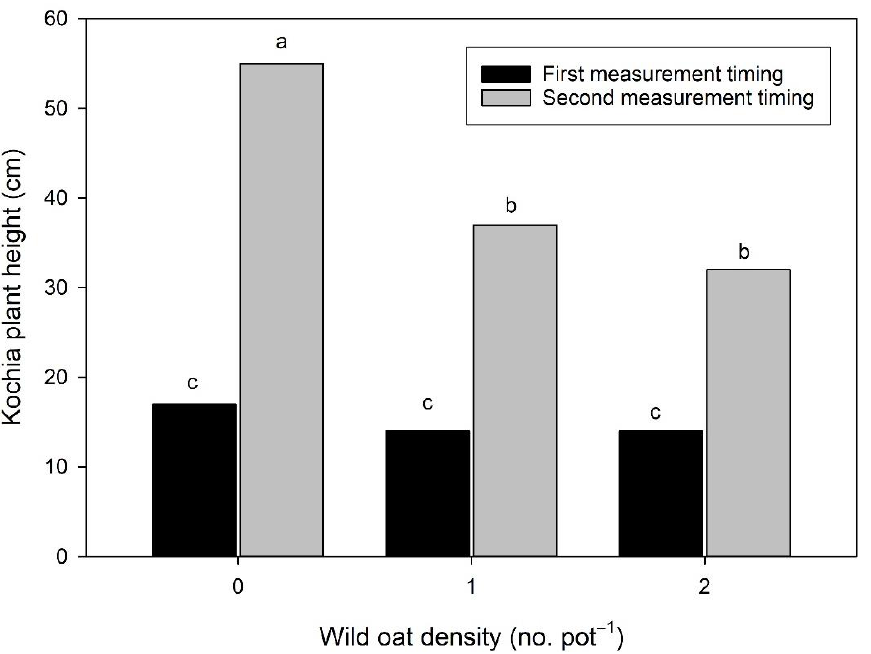
Figure 2. Back transformed least square estimates of kochia ( Kochia scoparia ) plant heights as impacted by wild oat ( Avena fatua ) density over time when grown in a greenhouse in Saskatoon, SK, in 2019 to 2020. Plants were grown in 13 cm diameter round pots filled with potting soil. Data were pooled over two experimental runs. Different letter groups indicate a significant difference using Tukey’s honest significance test ( p = 0.05). Results are pooled for both experimental runs.